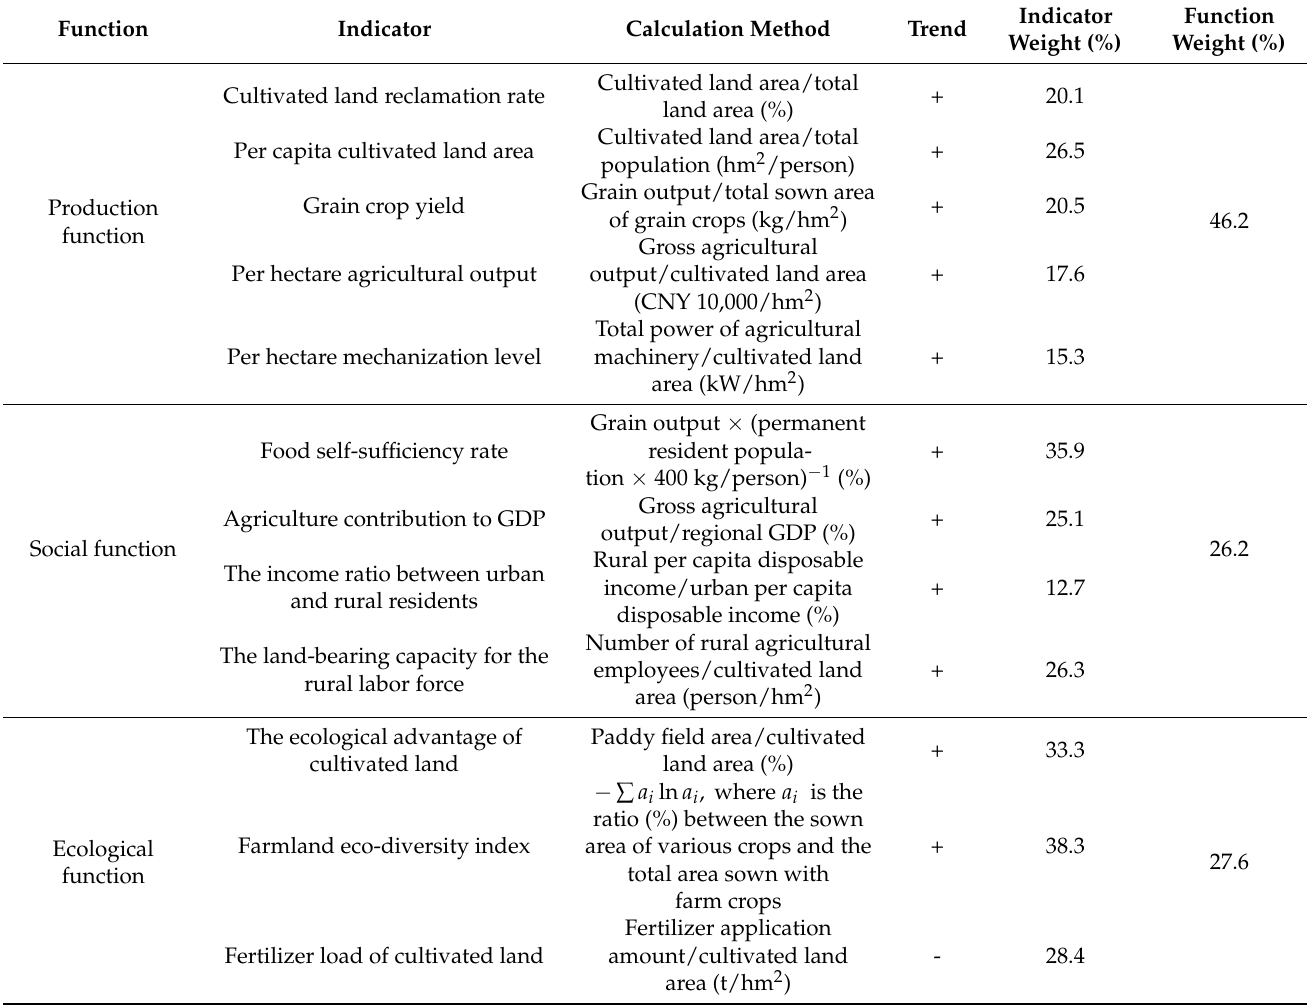
Table 1. Multifunctional cultivated land evaluation